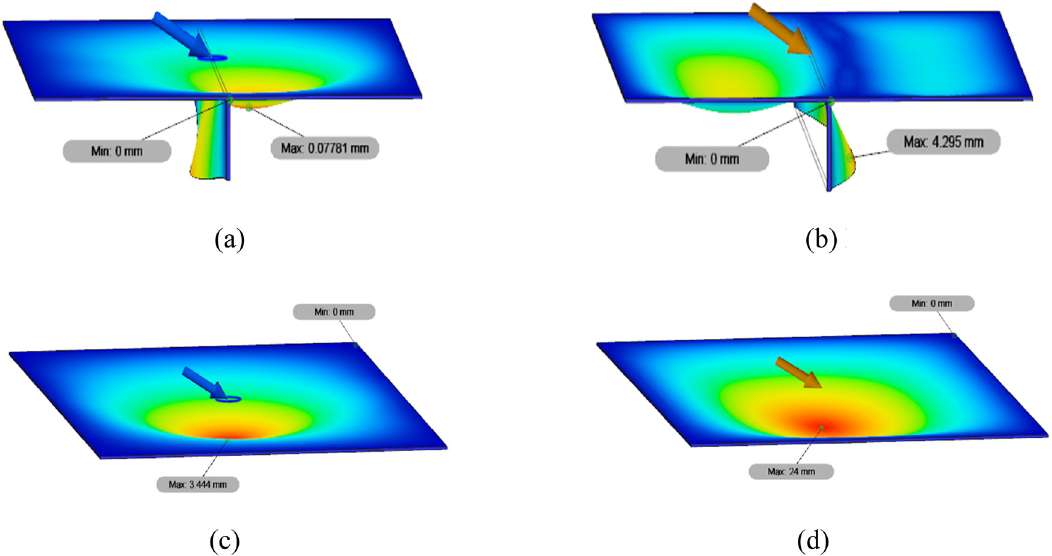
Figure 15: The displacement contour at a load angle of 60° between sti ff ened and unsti ff ened low - carbon steel plates with a centred load ( Models 5 and 7 ) and a global linear load ( Models 6 and 8 ) : ( a ) Model 5, ( b ) Model 6, ( c ) Model 7, and ( d ) Model